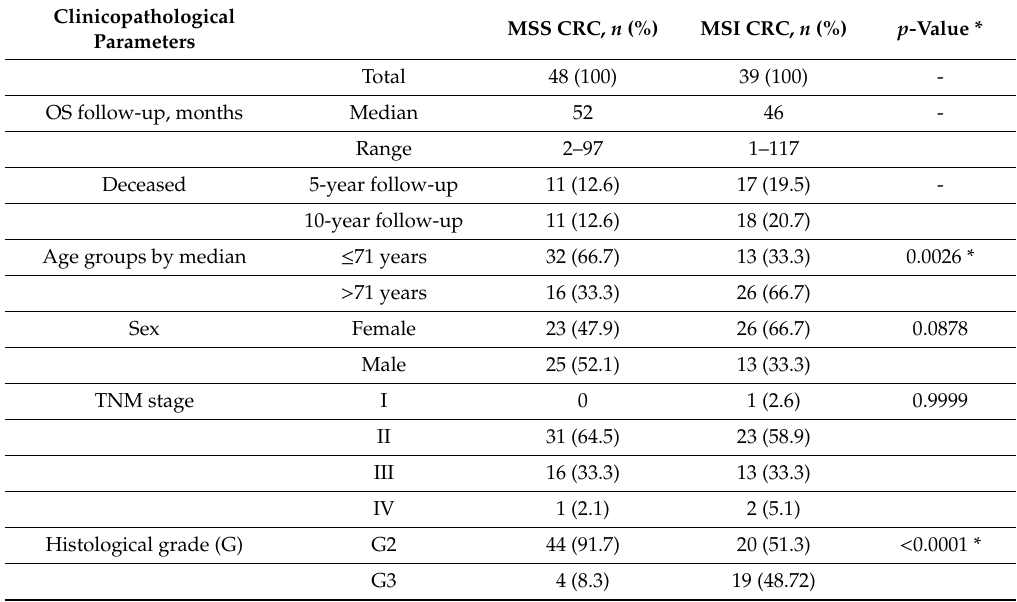
Table 1. Clinicopathological parameters in patients grouped by tumor microsatellite instability